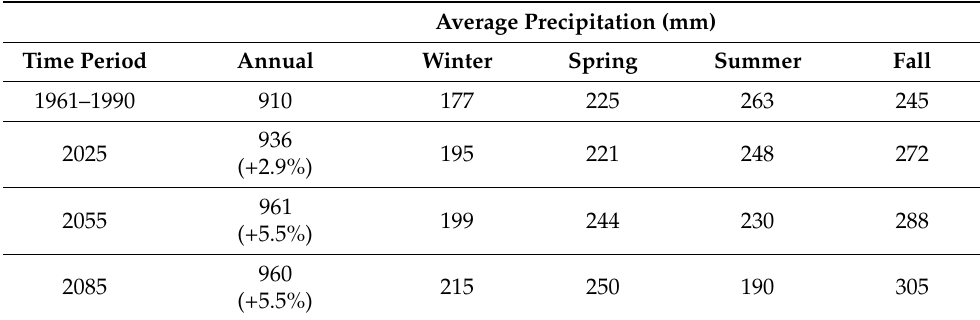
Table 2. Historical and projected average precipitations for the years 1961–1990, 2025, 2055 and 2085 obtained using the CanESM2_rcp85 model.